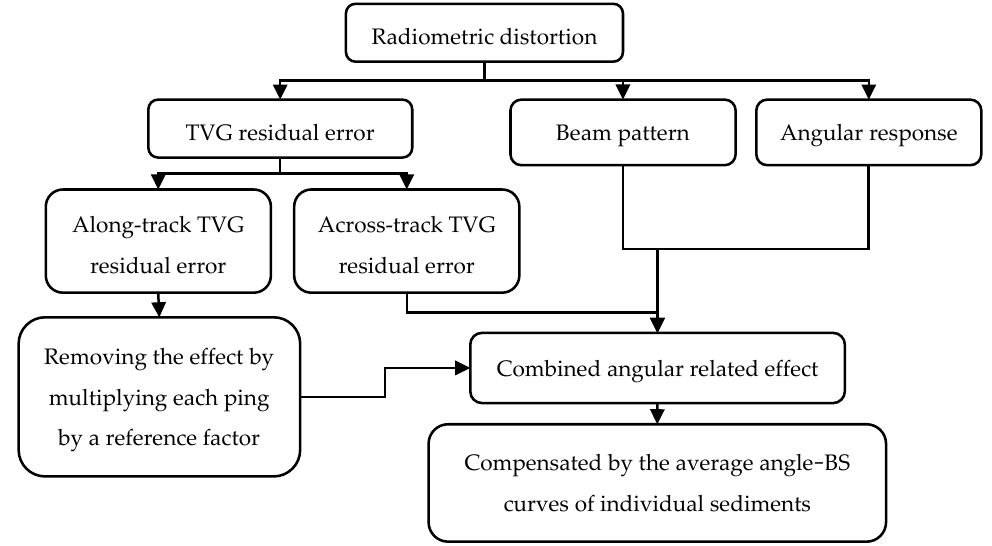
Figure 4. Flow chart of radiometric distortion correction in SSS data.